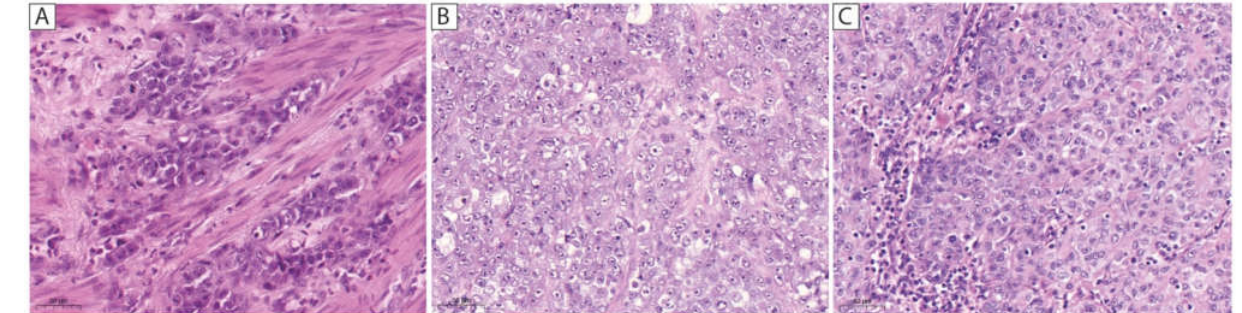
Figure 1. H&E (hematoxylin and eosin) images of the three cases with complete loss of SMARCA4 expression. All three cases ( A – C ) show an anaplastic solid and rhabdoid growth pattern. ( A ) The tumor shows overexpression of p53, expression of CK7, CK20, CDX2, EMA, and no expression of vimentin. ( B ) In this case expression of SMARCA2 and E-cadherin is completely lost. CK7, CK20, and CDX2 are not expressed whereas vimentin and EMA are expressed. ( C ) This tumor shows complete loss of E-Cadherin, expression of CK20, CDX2, EMA and no expression of CK7 and vimentin. Scale bar = 50 µm.